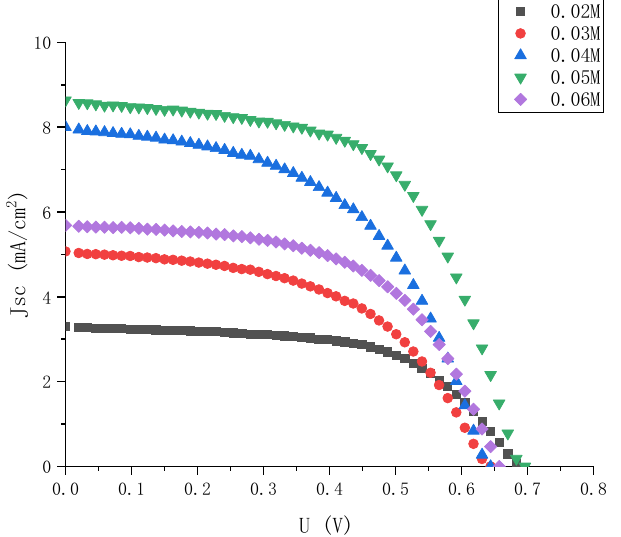
Figure 4. J-V characteristic curve of electrolyte solar cells with high gradient and different iodine concentrations.